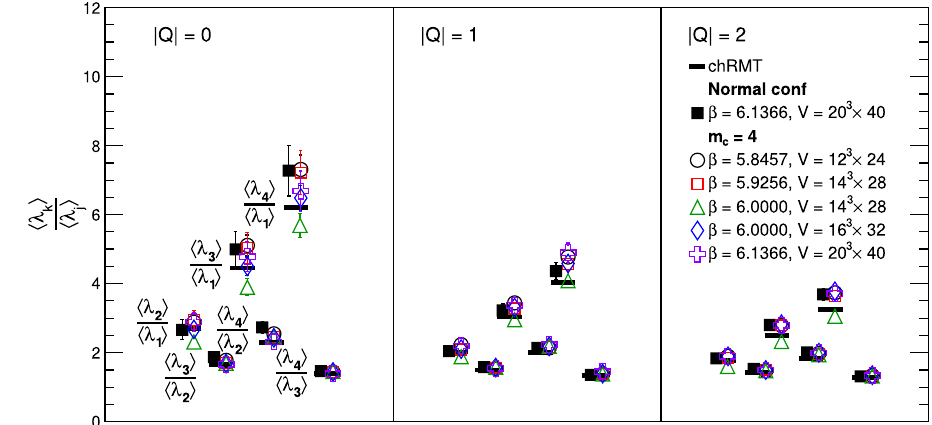
(upper and lower right). The black dotted, full, and dashed lines rep- resent the prediction functions of the GSE, GUE, and GOE of the GRMT, respectively. The colored lines and symbols indicatethe numer- ical results